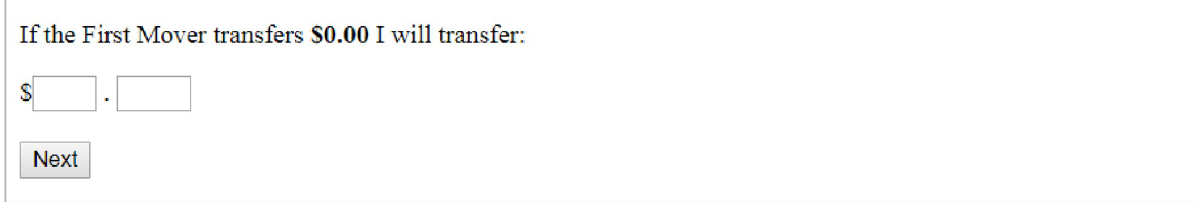
Fig 2. Screenshot example—Elicitation of SM transfer in response to FM transfer of $0.